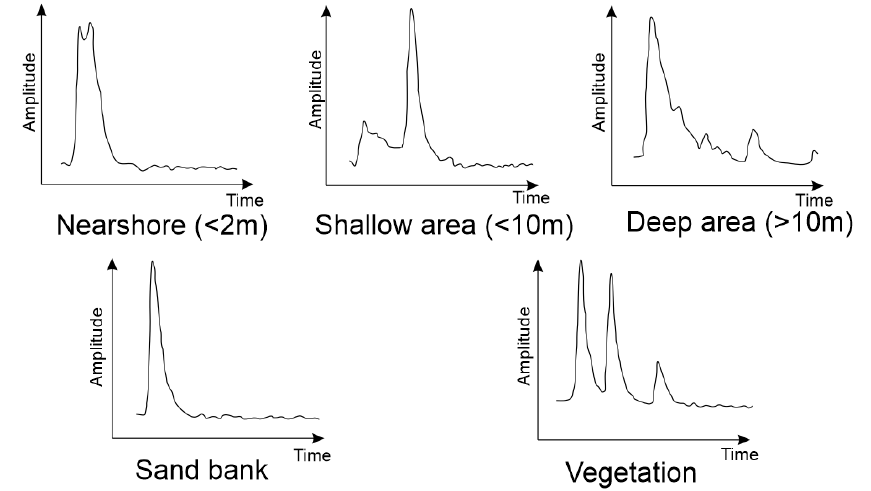
Figure 10. Echo responses for bottom topography elements (based on [105]).